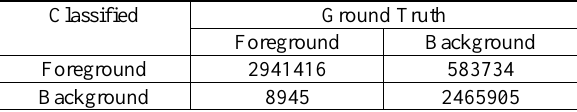
Table 1. The confusion matrix for the result of segmentation without Grabcut.